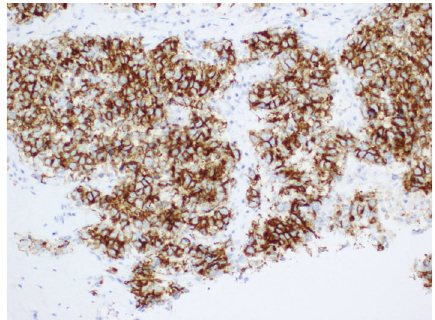
Figure 5: CT abdomen after development of hemorrhagic shock showedmultipleheterogeneouslyenhancingmassesintheliverwith peripheral enhancement. Also, there is intraperitoneal